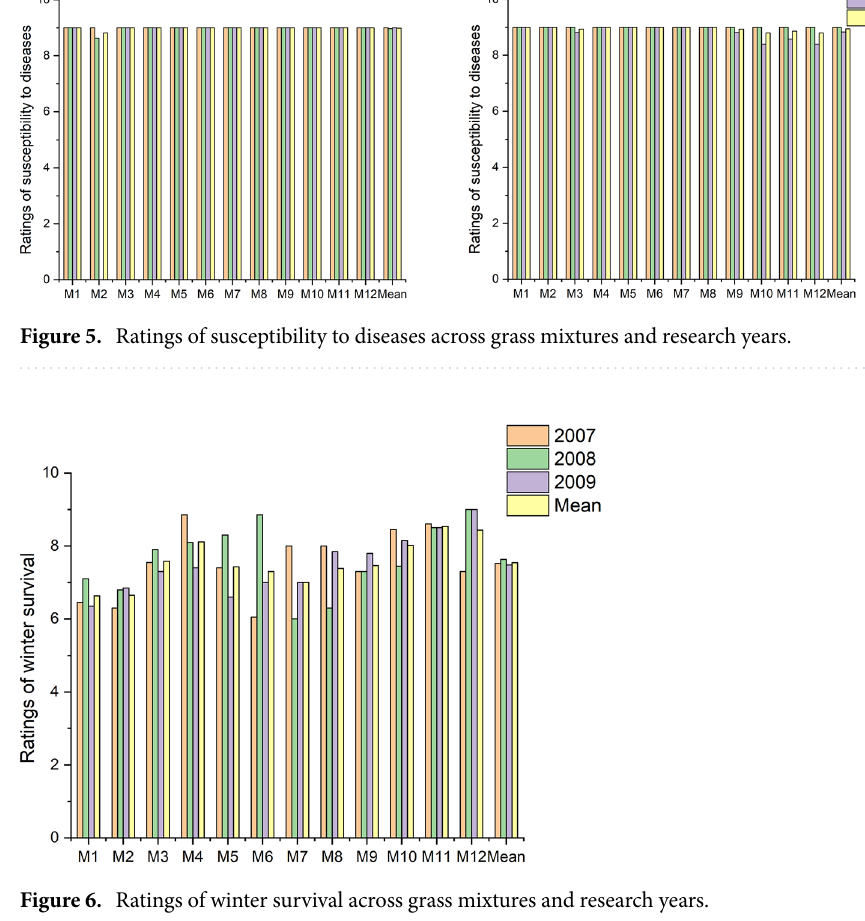
Figure 6. Ratings of winter survival across grass mixtures and research